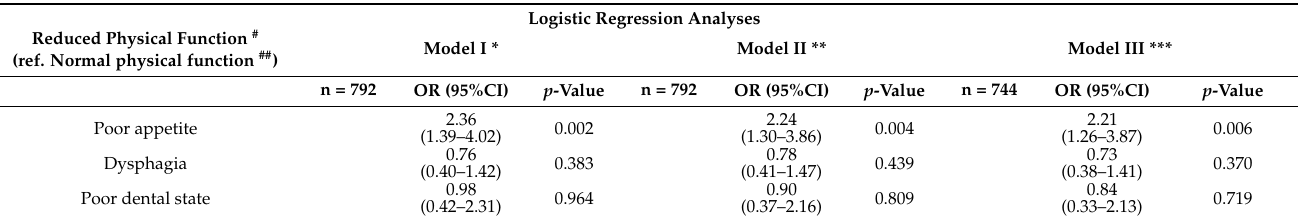
Table 4. Associations between reduced physical function and malnutrition risk factors in weight stable participants